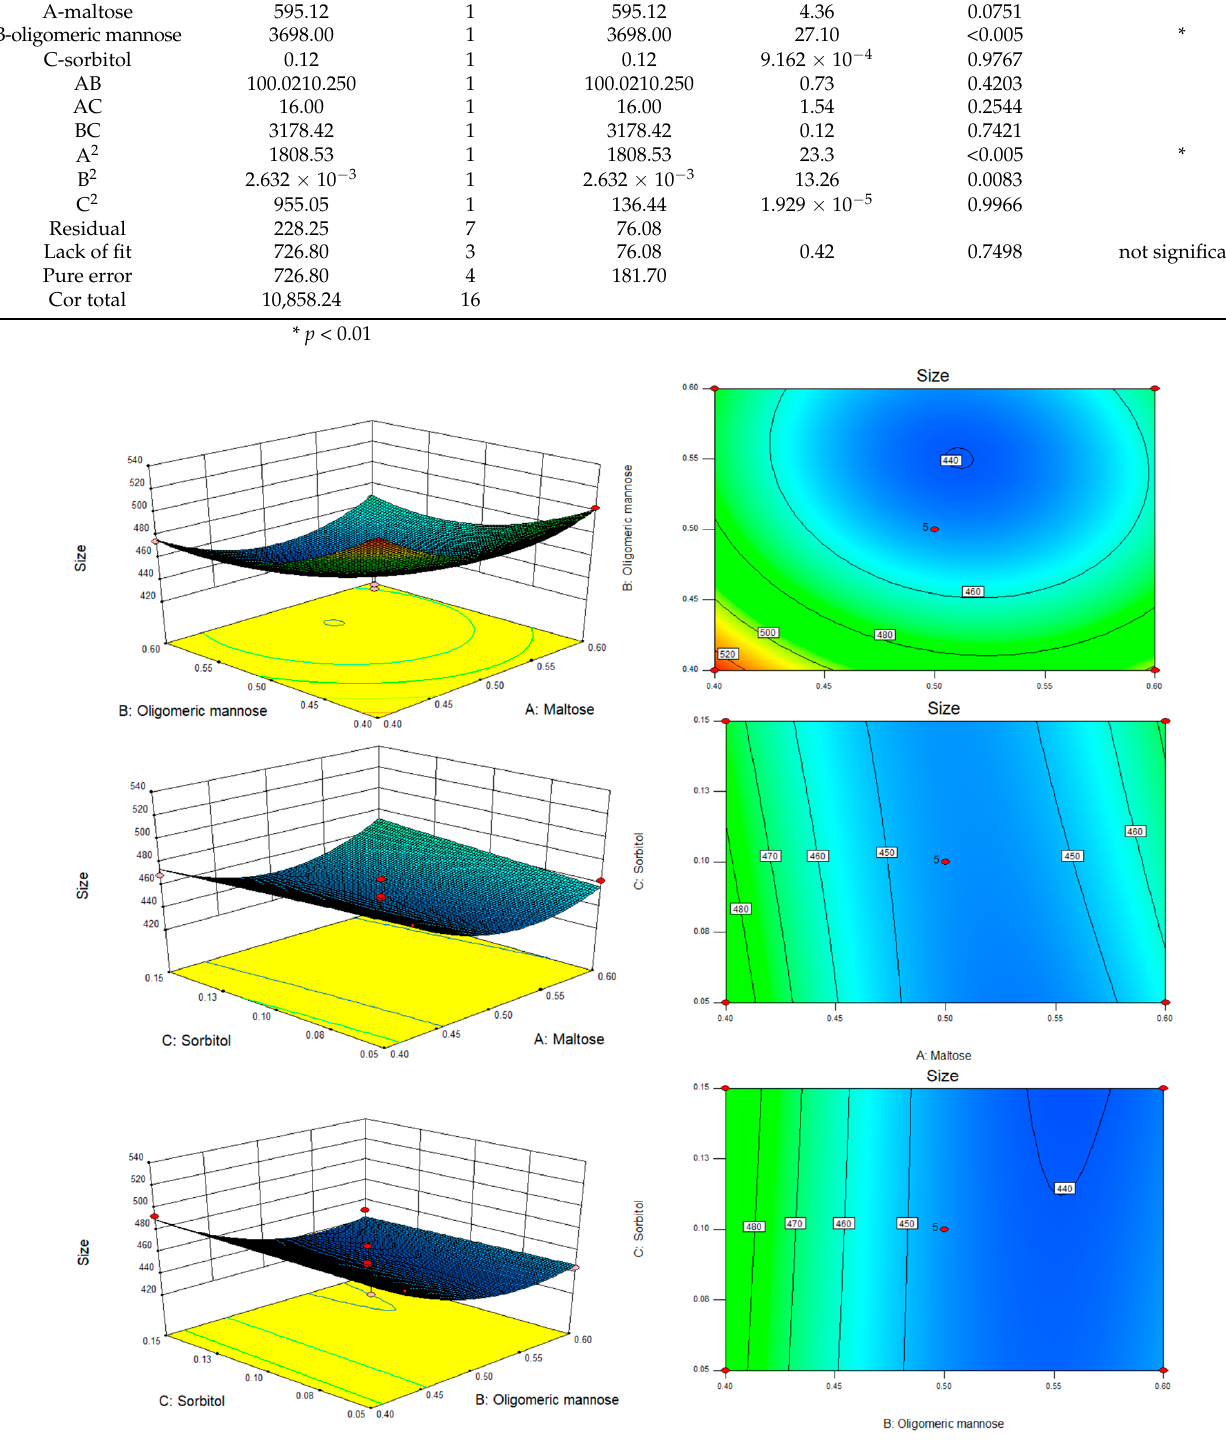
Figure 6. Response surface plots showing the effect of maltose (A), oligomeric mannose (B), and sorbitol (C) on the particle size of ABC-NPs.